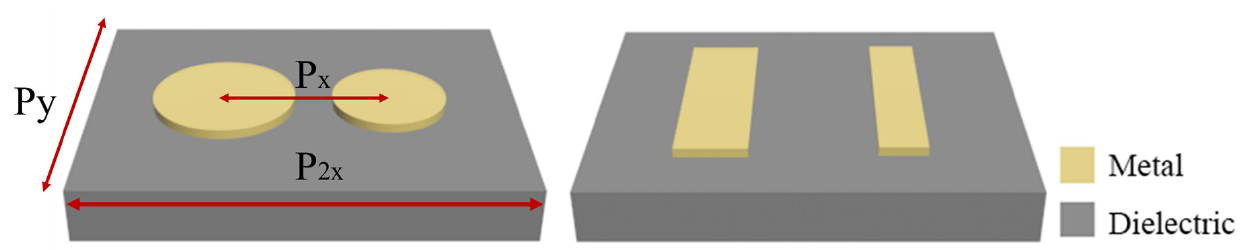
Figure 5. Examples of using asymmetric metallic structures such as disks or rods on a dielectric slab to realize the QGMs effect.